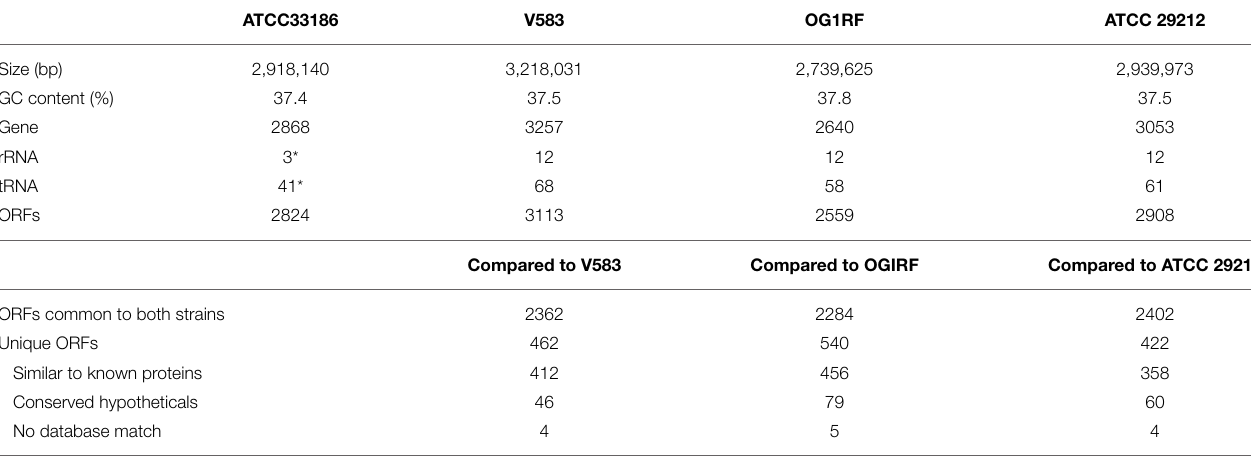
TABLE 2 | Gene features of ATCC33186, compared to V583, OG1RF, and ATCC